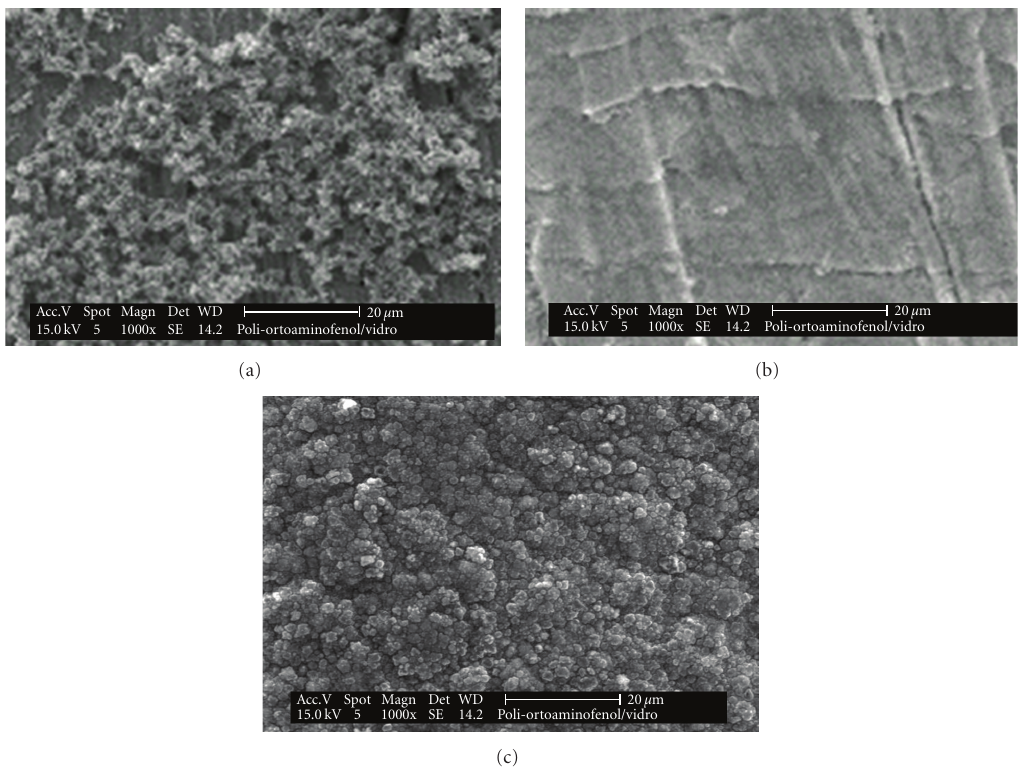
Figure 5: SEM images of the PANI (a), POAP (b) and PANI-POAP (c) films grown on an ITO electrode from 0.1 M ANI, 0.001 M OAP and 0.1M ANI + 0.001 M OAP solutions,